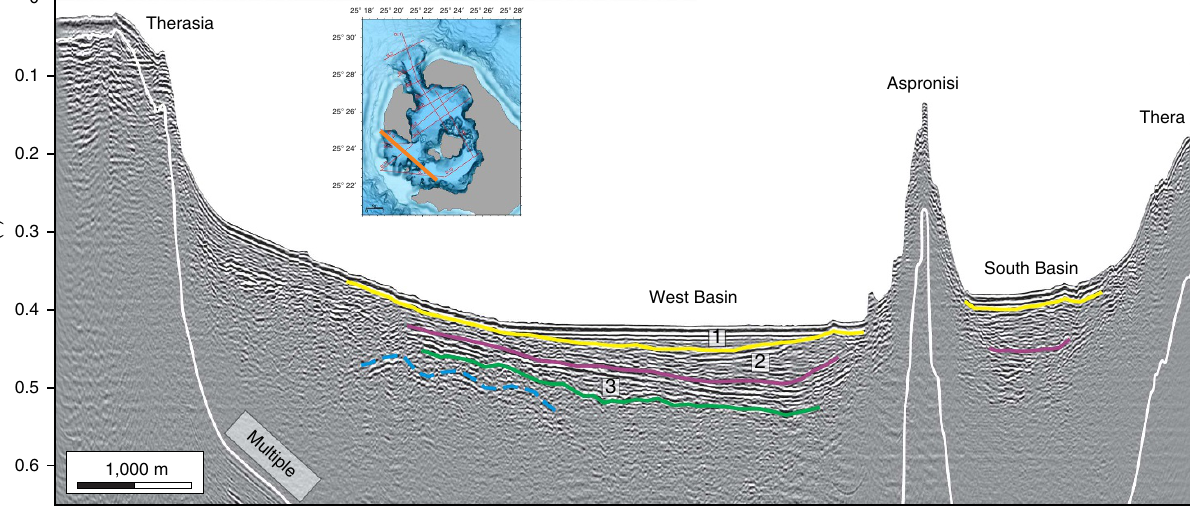
Figure 5 | Interpreted NW-SE sparker reflection seismic profile. This profile crosses the two SW straits, as shown by the orange line in the bathymetric map inset. Stratigraphic units 1–3 of ref. 10 are shown numbered; The dotted dark blue line indicates the presence of a deep, but poorly defined reflector. A TWT (two-way travel time) interval of 0.1s corresponds approximately to a water depth interval of 75m or a sediment interval of 100m. Please refer to Supplementary Fig. 3 for the uninterpreted seismic